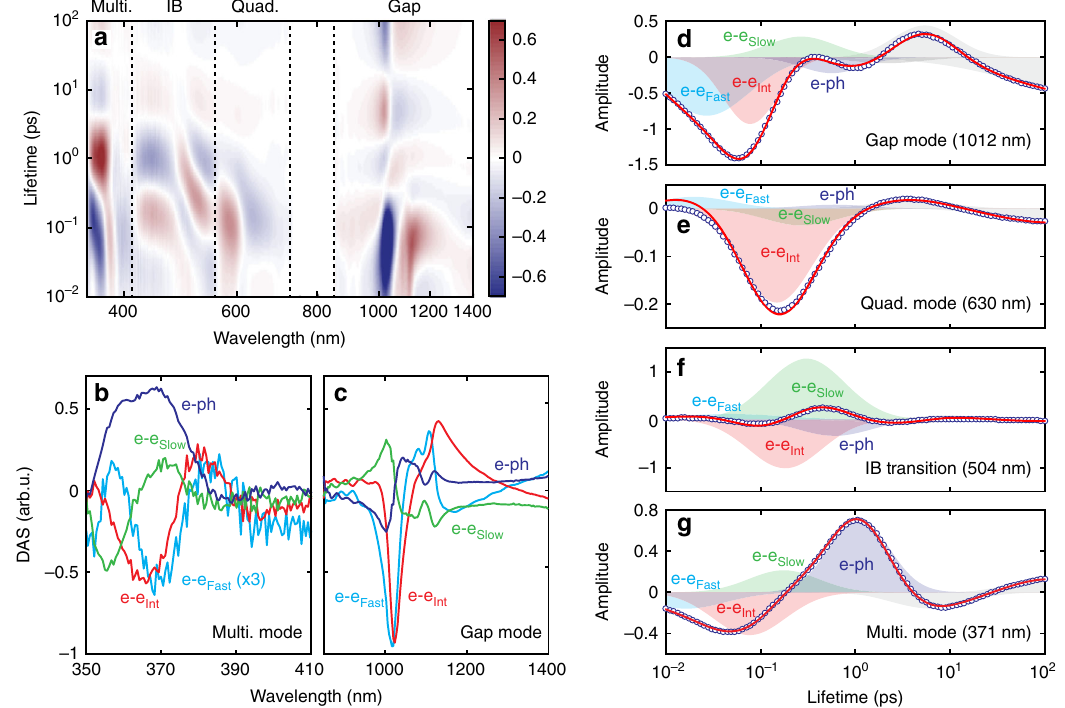
Fig. 7 Lifetime density analysis of the ultrafast response. a Lifetime density map (LDM) fi tted to the differential absorbance data in Fig. 6 and displayed on a log – log scale. Multiple distinct peaks can be observed spanning the entire range of lifetimes at each resonance. b , c Comparison of the decay-associated spectra (DAS) corresponding to fast, intermediate (int), and slow nonthermal e – e scattering and thermal e – ph scattering at the multipolar and gap plasmon resonances. The small fl uctuations at 1100 nm are artifacts from residual pump scatter. d – g Lifetime traces of the LDM (blue circles) at the same wavelengths as the kinetics in Fig. 6e. Contributions from nonthermal electron – electron scattering and thermal electron – phonon scattering are indicated (shaded regions) along with the total fi tted response (red line). The gray regions are contributions from phonon – phonon scattering (~10 ps) and semi- in fi nite decay due to lattice heating (~100